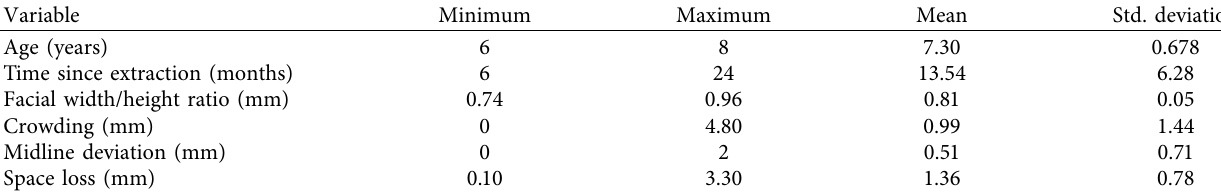
Table 2: Age, facial skeletal pattern, and space loss.